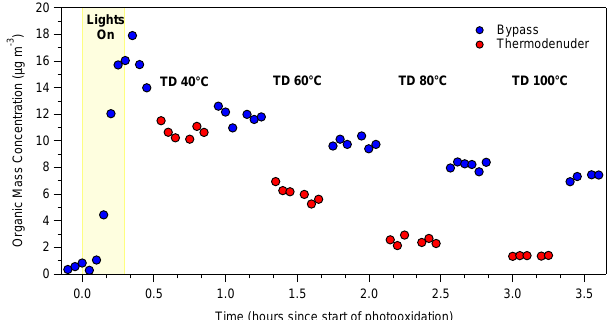
Figure 6. Bypass (blue) and thermodenuder (red) organic mass con- centration time series for Expt. 7. The yellow shaded region denotes time when the UV lights were on. Temperatures represent the TD setpoint temperature. The bypass data have not been corrected for losses to the walls of the chamber. The TD measurements have not been corrected for losses in the TD.